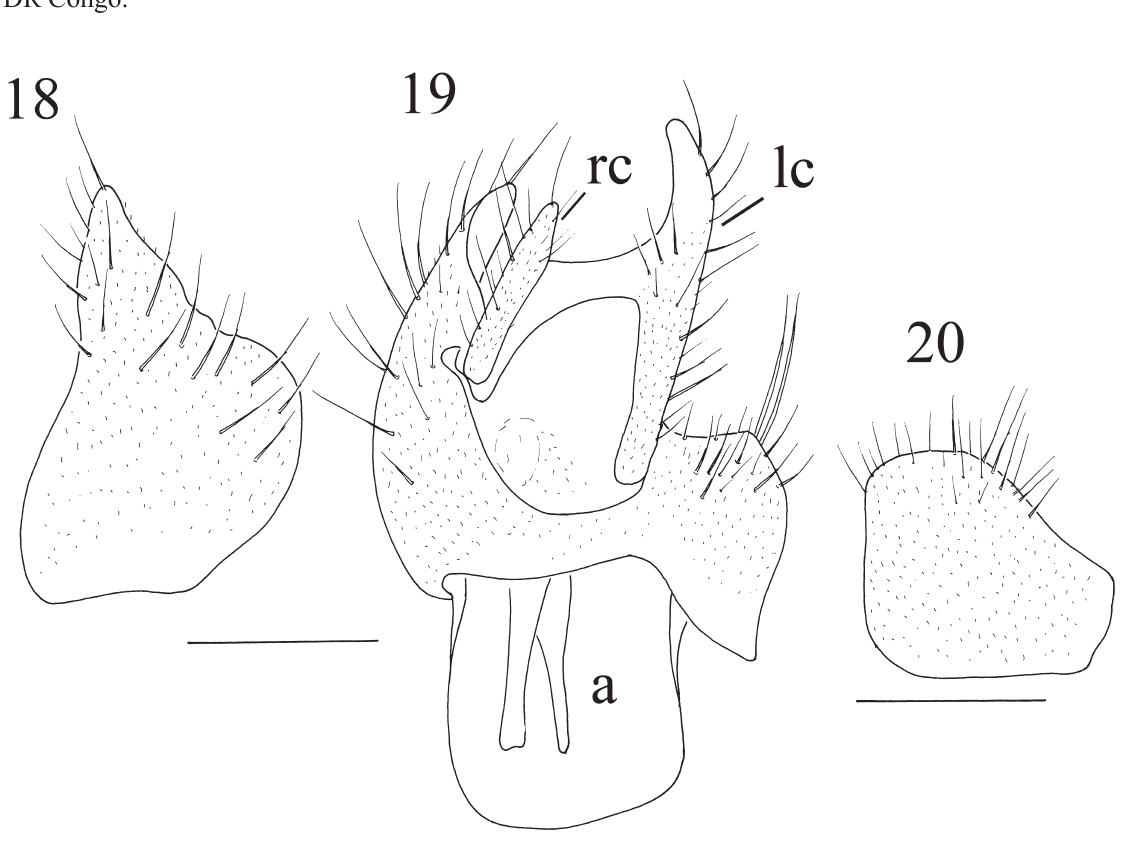
Figs 18–20. Platypalpus lokonda sp. nov., holotype ♂. 18 . Right epandrial lamella. 19 . Epandrium with cerci, dorsal view. 20 . Left epandrial lamella. Scale bars = 0.1